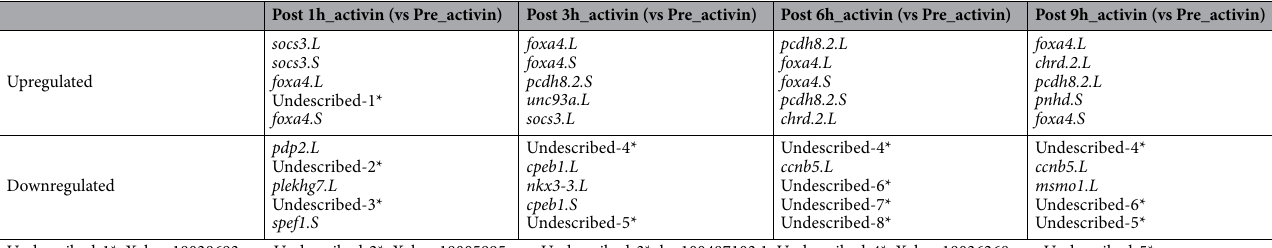
Table 1. List of top five upregulated and downregulated DEGs. DEGs were identified in the comparison of each Post_activin vs. Pre_activin sample. Sequences that did not show the significant hits or annotations (listed as model IDs starting with “loc” and “Xelaev”) were represented as undescribed 1–8. X. laevis is an allotetraploid, and contains two sets of genes, L and S